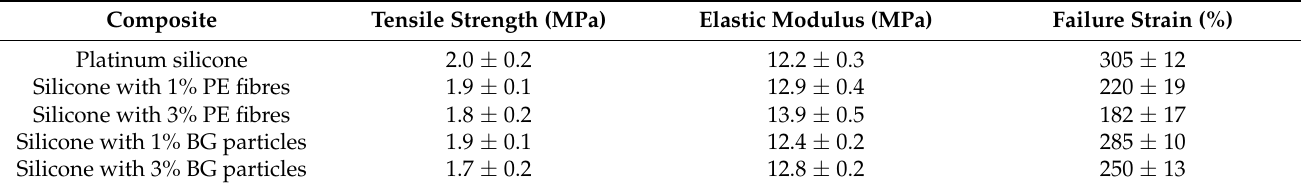
Table 1. Tensile properties of platinum silicone and the composites with two different reinforcements of 1% and 3%